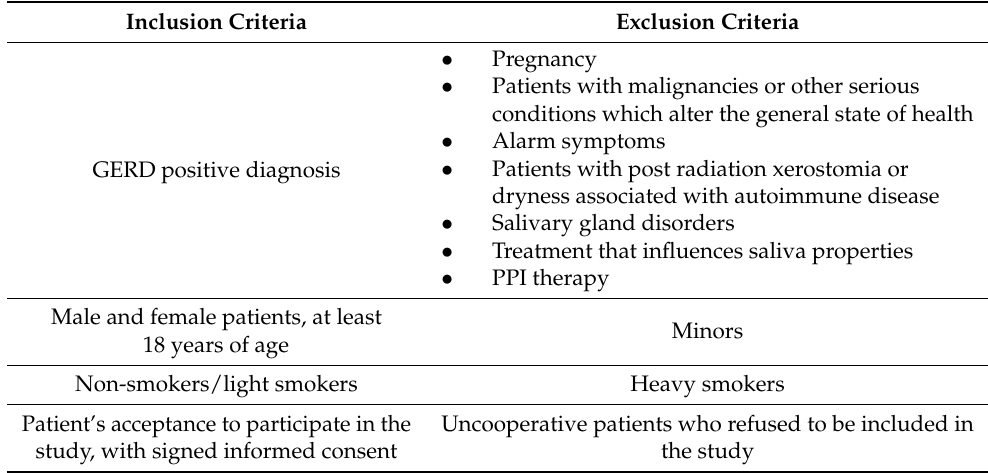
Table 1. Inclusion and exclusion criteria in the study